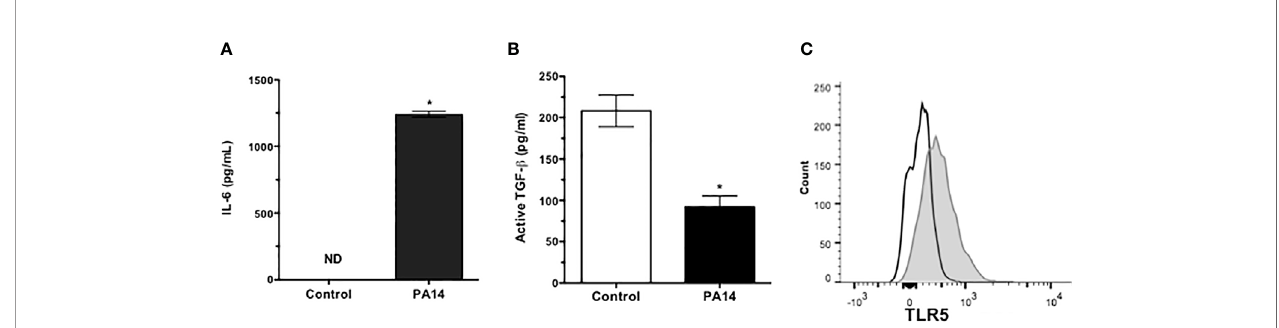
FIGURE 2 | Goblet cells express functional TLR5 and respond to pathogenic strain of P. aeruginosa by reducing active TGF b secretion. Levels of (A) IL-6 and (B) active TGF b in culture supernatants of GCs stimulated with heat-inactivated PA14 for 24 h. ND, Not Detected. Data are expressed as mean ± SEM, n = 4, * p < 0.05. (C) Flow cytometric detection of surface expression of TLR5 in primary cultures of GCs. Filled histogram shows positively stained GCs and empty histogram represents isotype